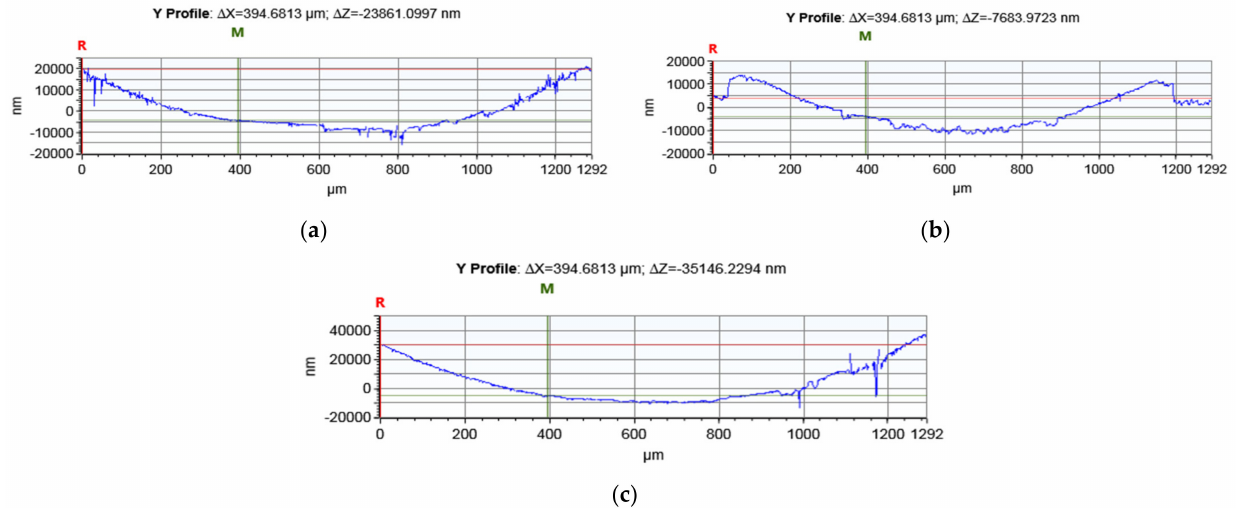
Figure 8. The surface profiles of the substrate, Babbitt B83, and the running-in coatings after tribolog- ical testing: ( a ) the tin bronze substrate; ( b ) Babbitt B83; ( c ) the running-in coatings of specimen